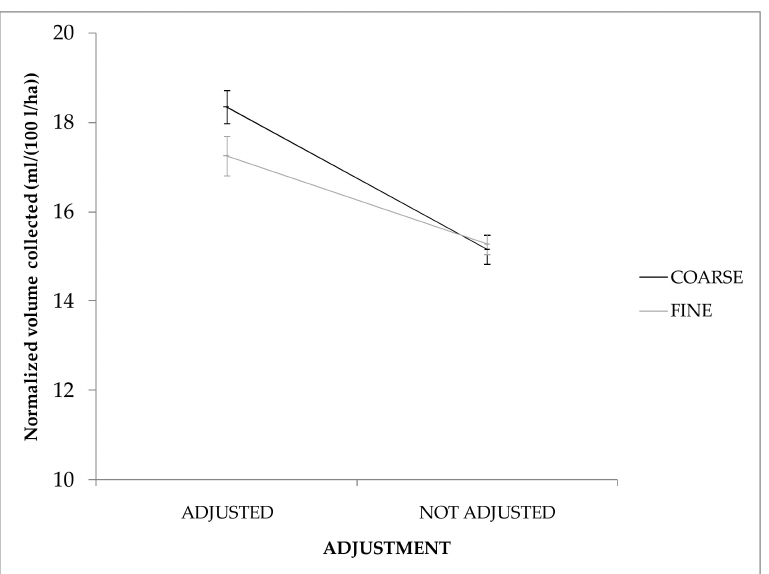
Figure 11. Adjustment × Nozzle type interaction effect on the normalized volume collected in the canopy zone (mean ± SE) with the T